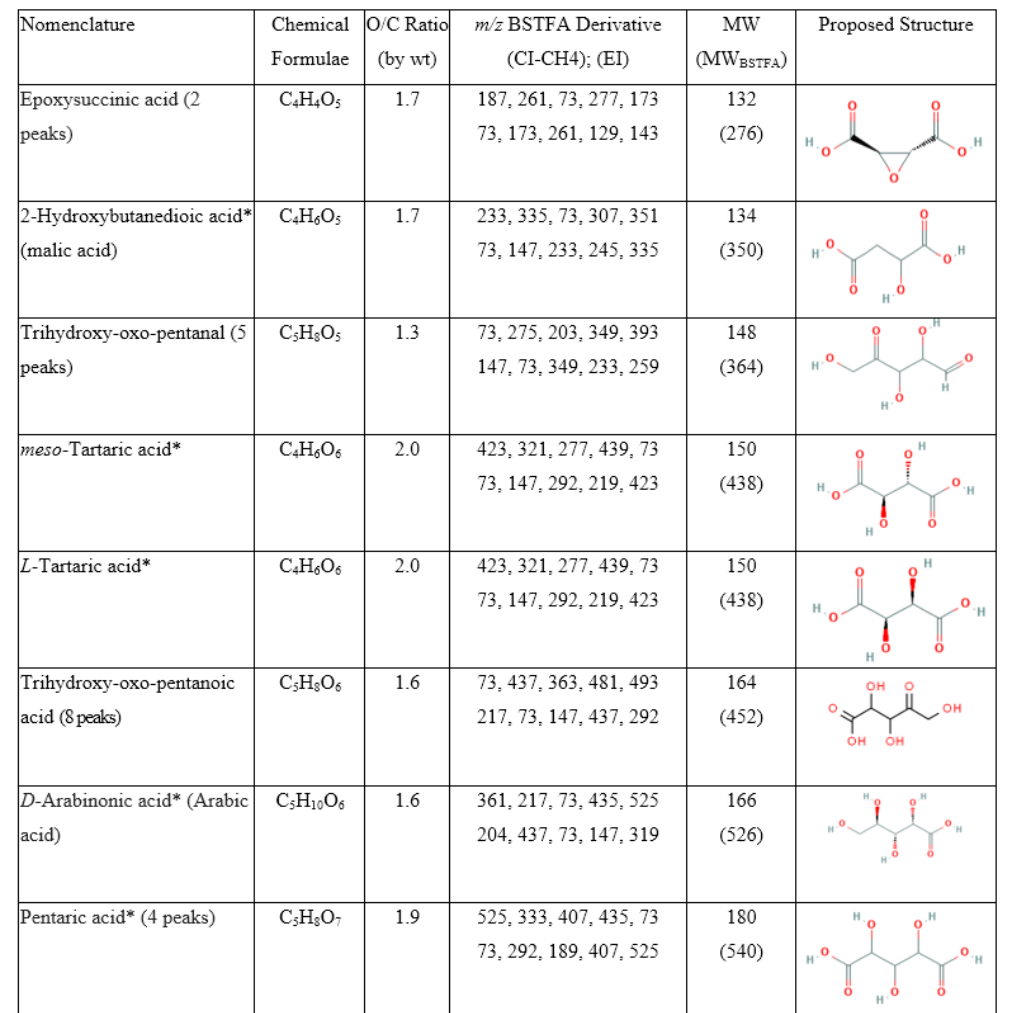
Table 6. Highly oxygenated products (O : C > 1 . 3) identified in benzyl alcohol photooxidation in the presence of NO x or H 2 O 2 . *Identified with an authentic standard. L -Tartaric acid and D -tartaric acid co-elute. The structures of the 4-oxo- D -arabonic acid isomer and 2,3,5- trihydroxy-4-oxopentanal isomer are shown for trihydroxy-oxo-pentanoic acid and trihydroxy-oxo-pentanal, respectively. Four peaks with similar fragments and/or adducts as pentaric acid were